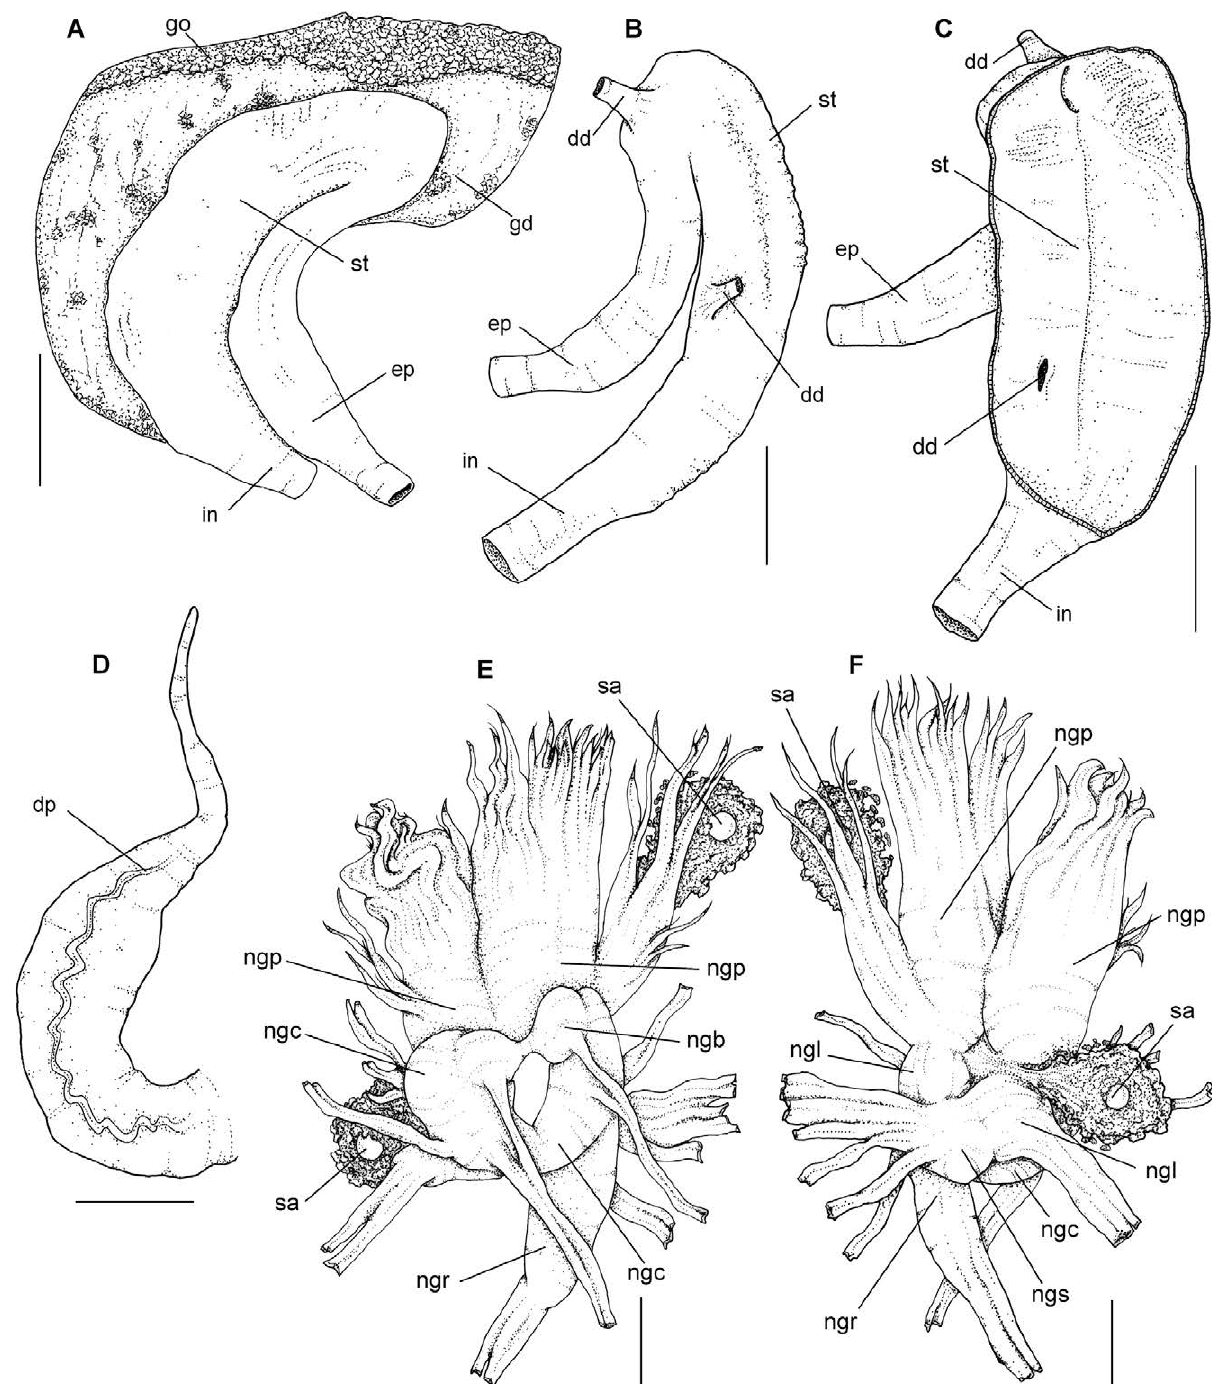
Fig. 9. – Hemipolygona beckyae . A, stomach in dorsal view; B, stomach in ventral view; C, stomach shown internally; D, penis in dorsal; E, nerve ring in dorsal view; F, nerve ring in ventral view. Abbreviations: dd, duct of digestive gland; dp, duct of penis; ep, posterior esophagus; in, intestine; nbl, pleural ganglion; ngb, buccal ganglion; ngc, cerebral ganglion; ngp, pedal ganglion; ngr, supra-esophageal ganglion; ngs, subesophageal ganglion; sa, statocyst. Scale bars: A-D, 2 mm; E-F, 0.5